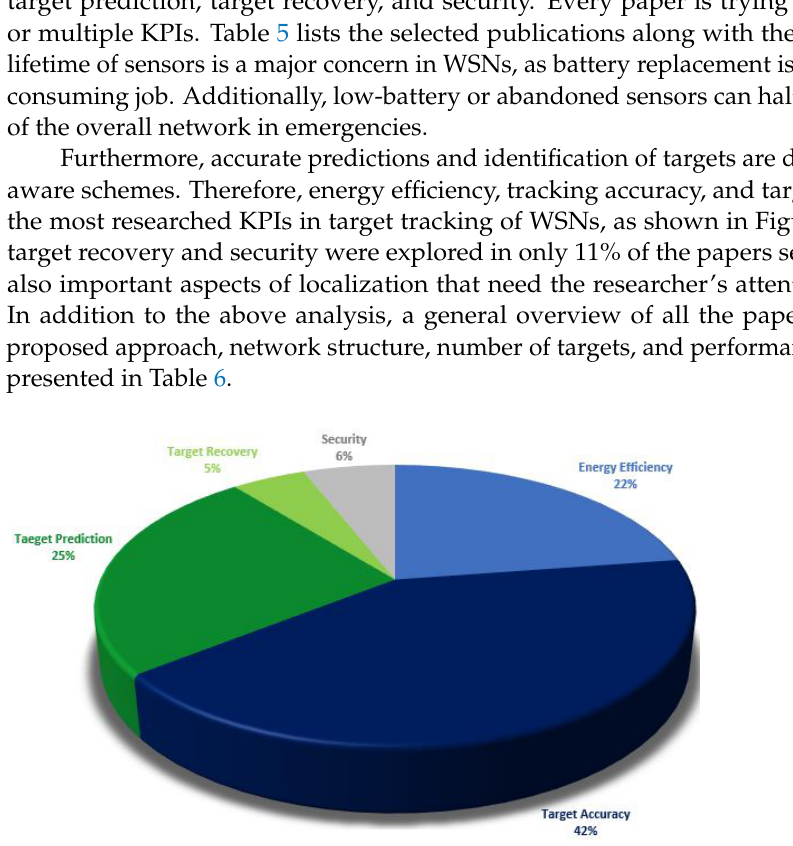
Figure 7. Distribution based on target challenges. Table 5. KPIs Addressed in Selected Papers.